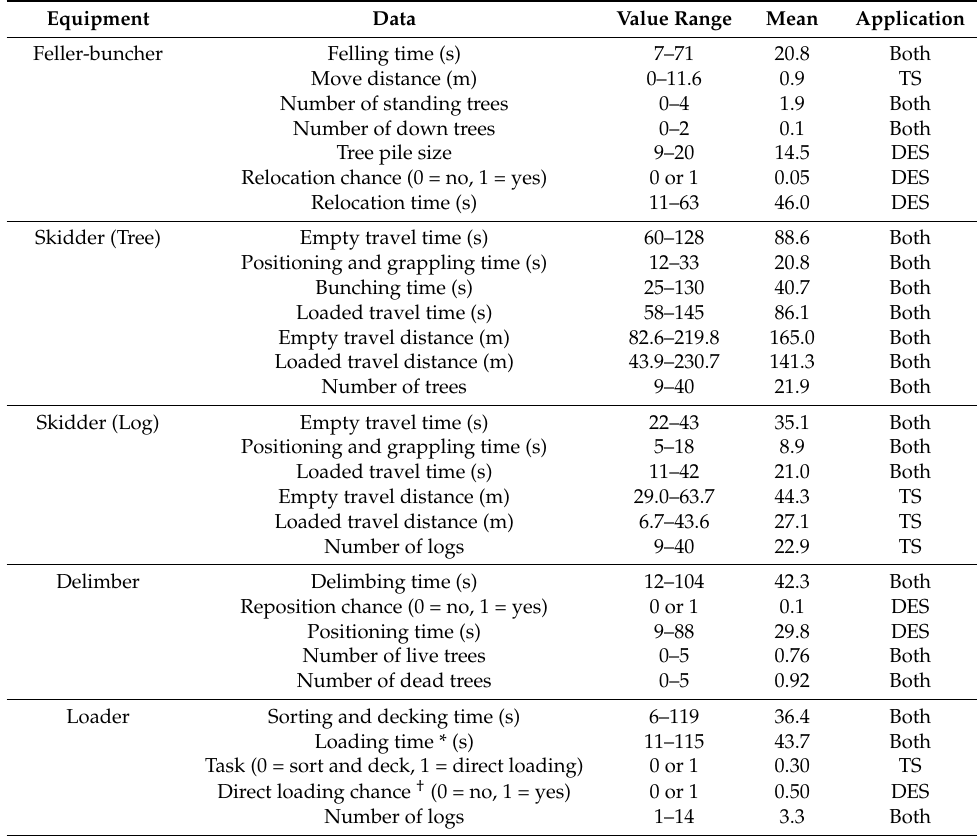
Table 1. Field-collected data and applications in models.